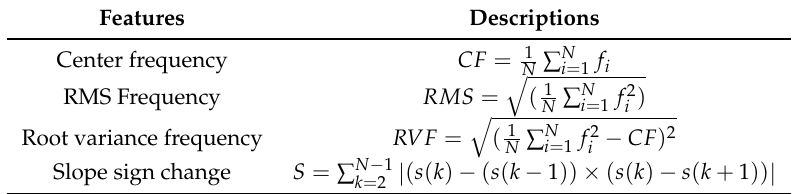
Table 1. Frequency domain features of accelerometer and gyroscope